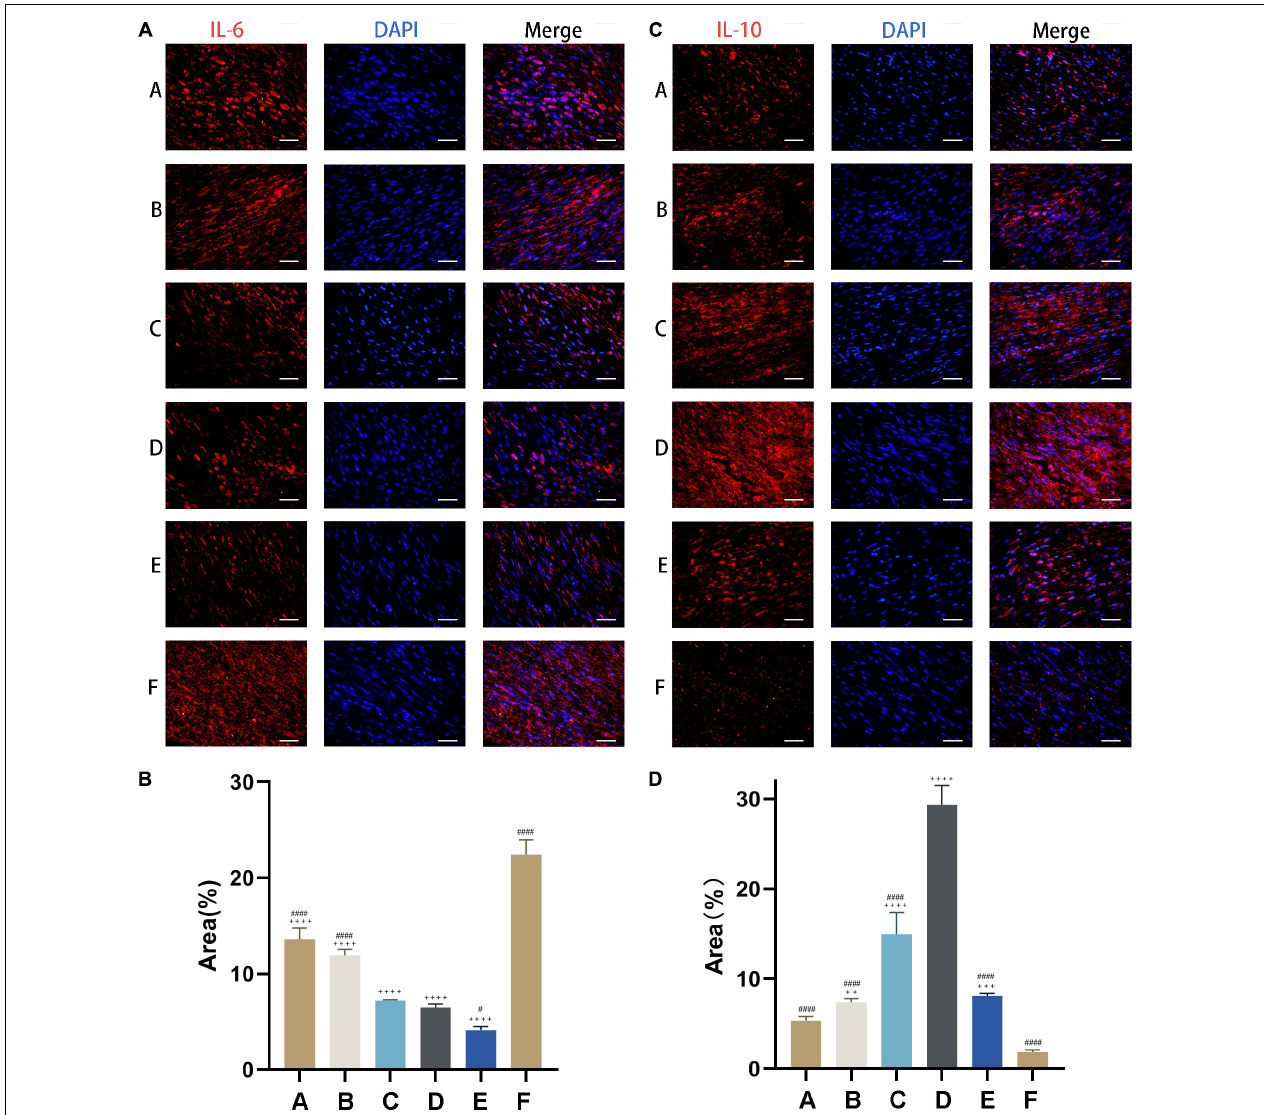
FIGURE 7 | CM suppresses inflammation in injured tendon. (A) Expression of the pro-inflammatory cytokine IL-6 (red) was detected by immunocytochemistry. Nuclei were stained with DAPI (blue). CM held the capacity of inhibiting pro-inflammatory cytokine expression. (B) Quantitative analysis of IL-6 expression levels based on the area of positive signal. (C) Expression of the anti-inflammatory cytokine IL-10 (red) was detected by immunocytochemistry. Nuclei were stained with DAPI (blue). CM held the capacity of promoting anti-inflammatory cytokine expression. (D) Quantitative analysis of IL-10 expression levels based on the area of positive signal. Bars: 50 µ m. #, versus D. # means p < 0.05, #### means p < 0.0001. + , versus F. ++ means p < 0.01, +++ means p < 0.001, ++++ means p < 0.0001.